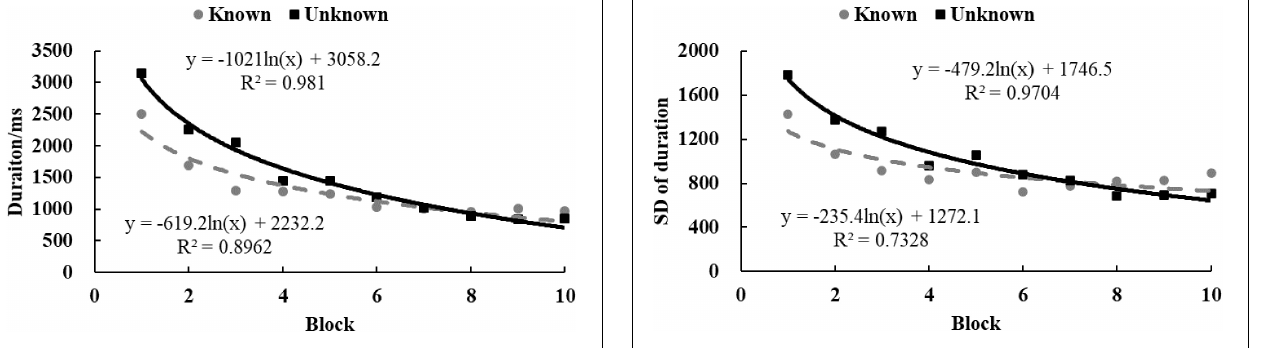
FIGURE 10 | The SD of decision time in Study 3. The solid and dotted lines represent the regression curves for the unknown and known conditions, respectively.